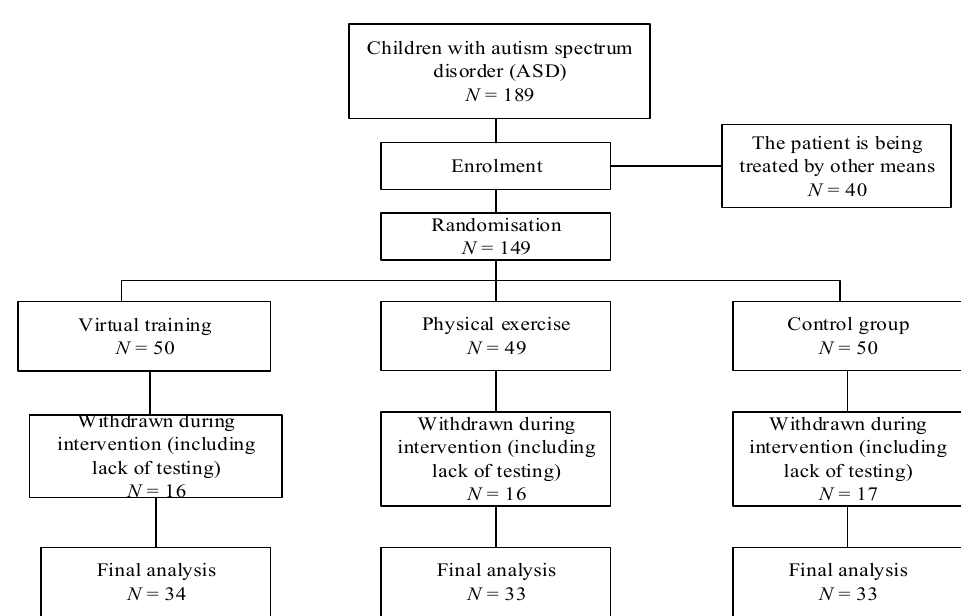
Figure 1. Participant flowchart across the study.